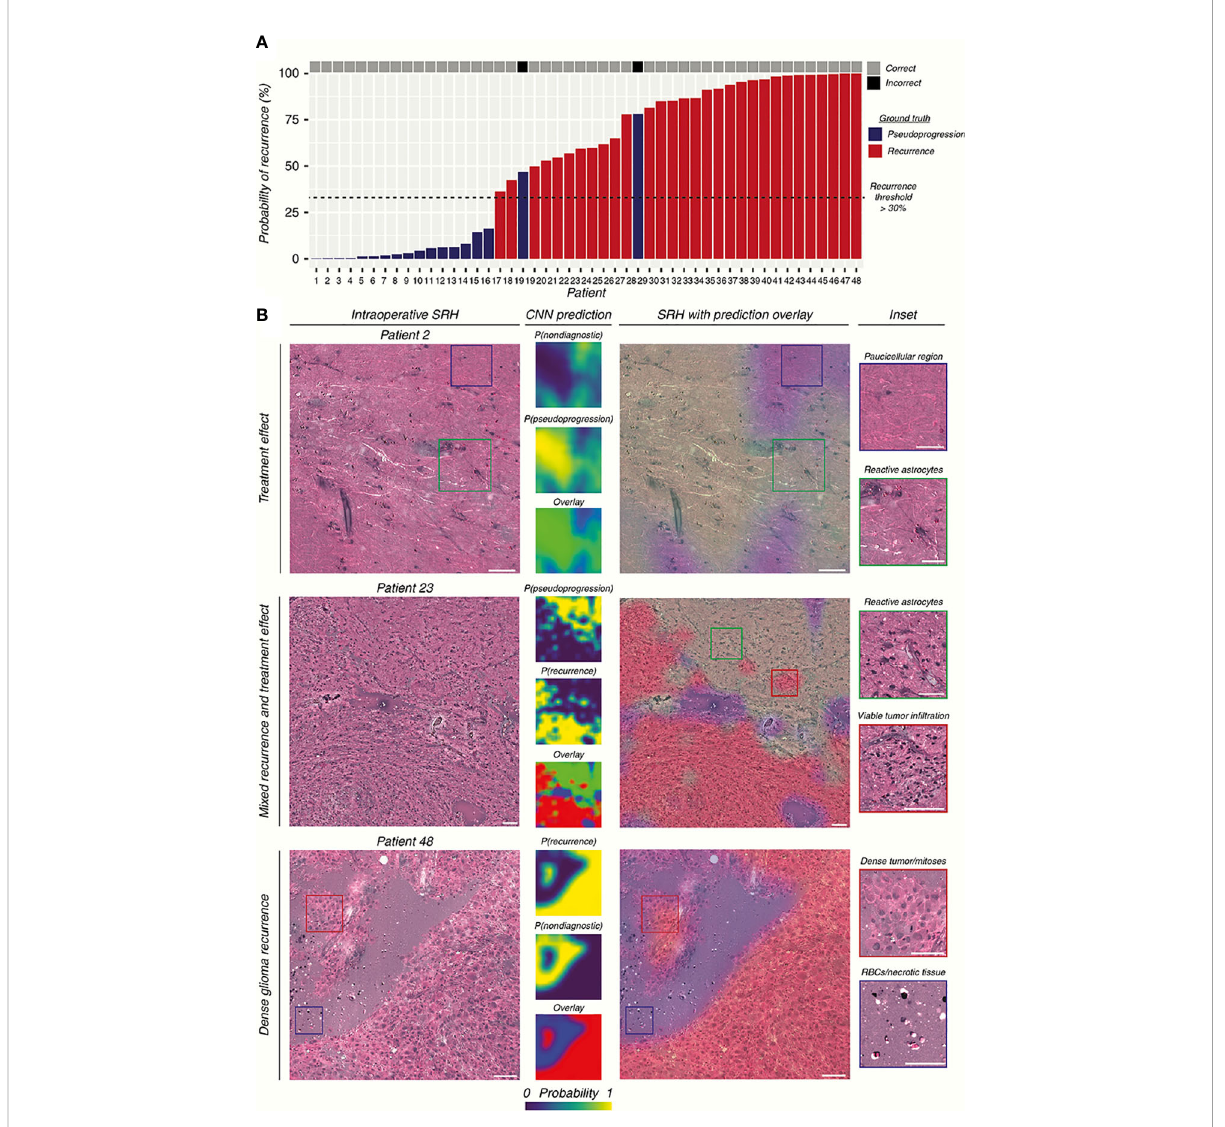
FIGURE 3 The researchers used CNN to construct the prediction model by SRH images. (A) The prediction results of the SRH-based prediction model are demonstrated. (B) SRH images and CNN probability heatmaps. The model was able to correctly identify pseudoprogression, tumor recurrence, and in fi ltrative glioma. Scale bars = 50 m m